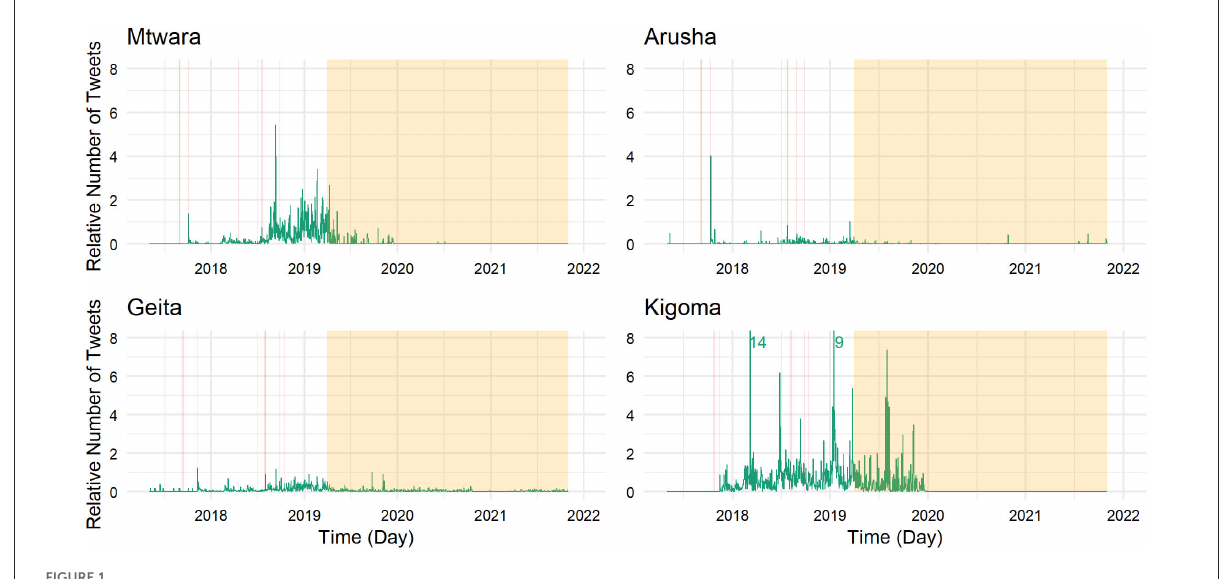
FIGURE1 Twitter activity of animators across time per region.